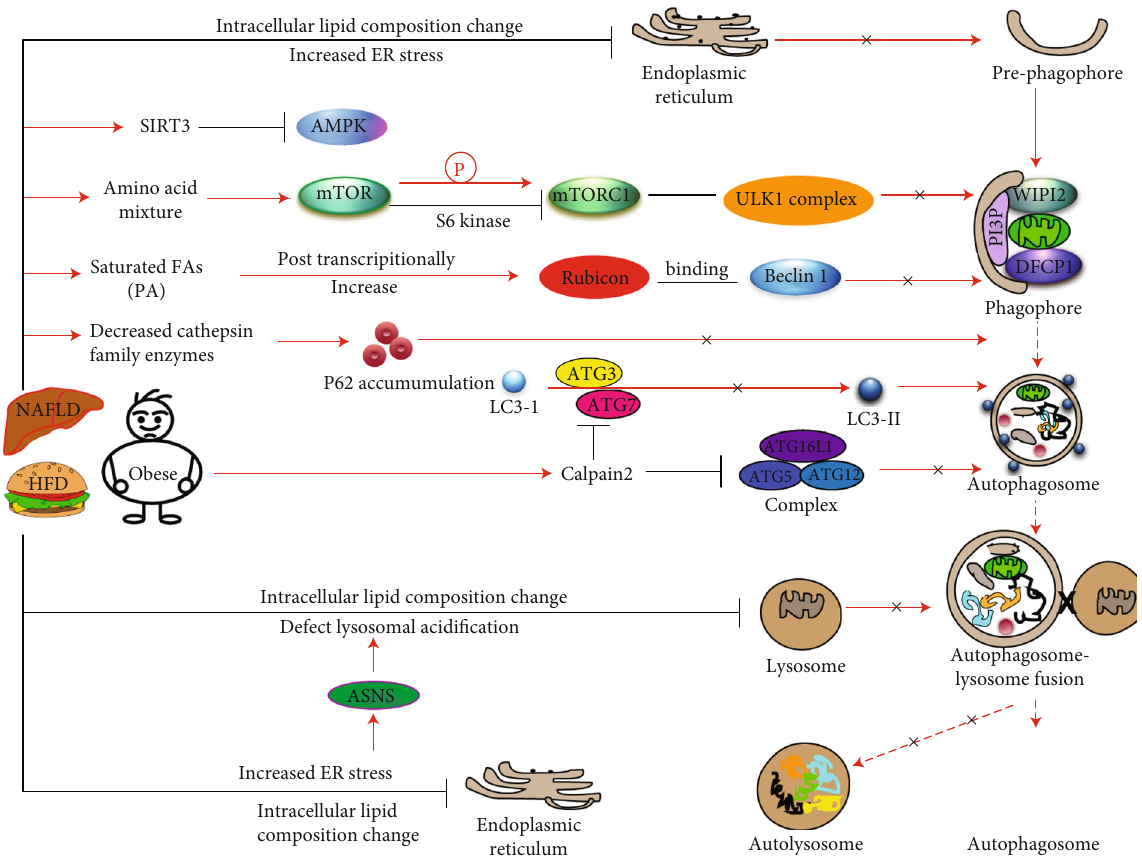
Figure 2: Schematic model represents the molecular mechanisms and dysregulation of autophagy components in a high-fat diet (HFD)/obesity-induced impaired autophagic function in NAFLD. HFD-/obesity-mediated activation of SIRT3 inactivates AMPK, mTORC1, and ULK1 complex leading to inhibition of phagophore formation. A high fatty acid diet upregulates Rubicon expression, increasing its interaction with Beclin 1 and decreasing autophagosome-lysosome fusion. HFD/obesity decreases the expression and activities of cathepsin family enzymes and downregulates autolysosomal proteolysis. HFD/obesity induces changes in the membrane lipid composition of the lysosome, a ff ects autophagosomal-lysosomal acidi fi cation, and inhibits fusion of the autophagosome with the